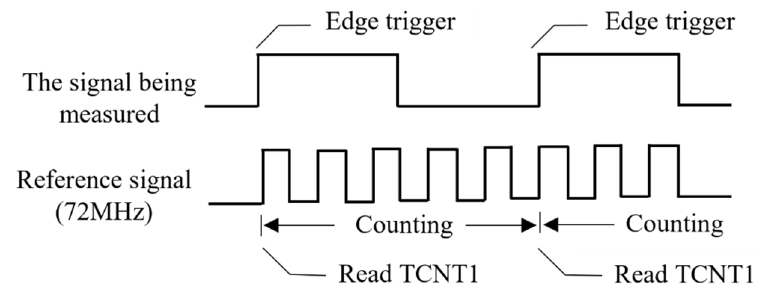
Figure 9. Frequency measurement timing diagram.